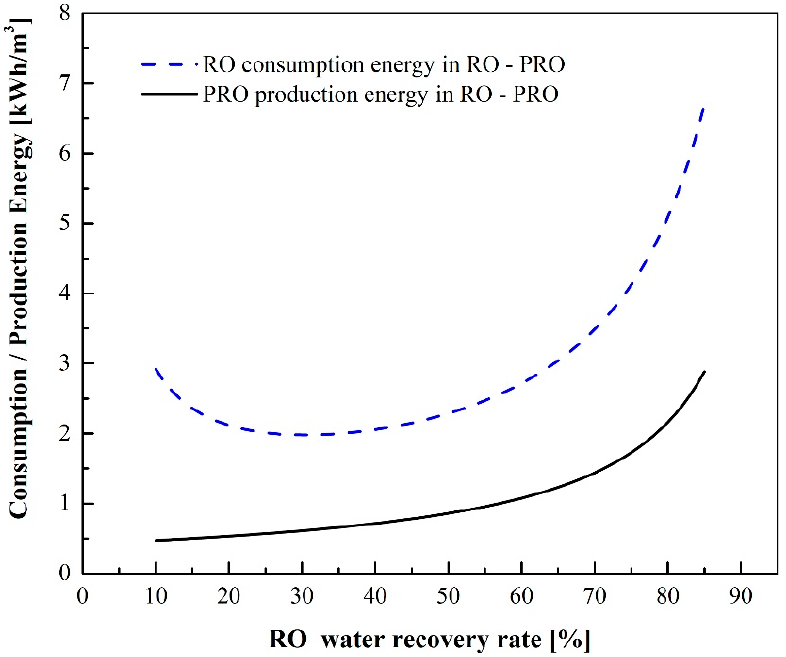
Figure 7. Comparison of RO energy consumption and PRO energy production in the RO-PRO pro- cess.